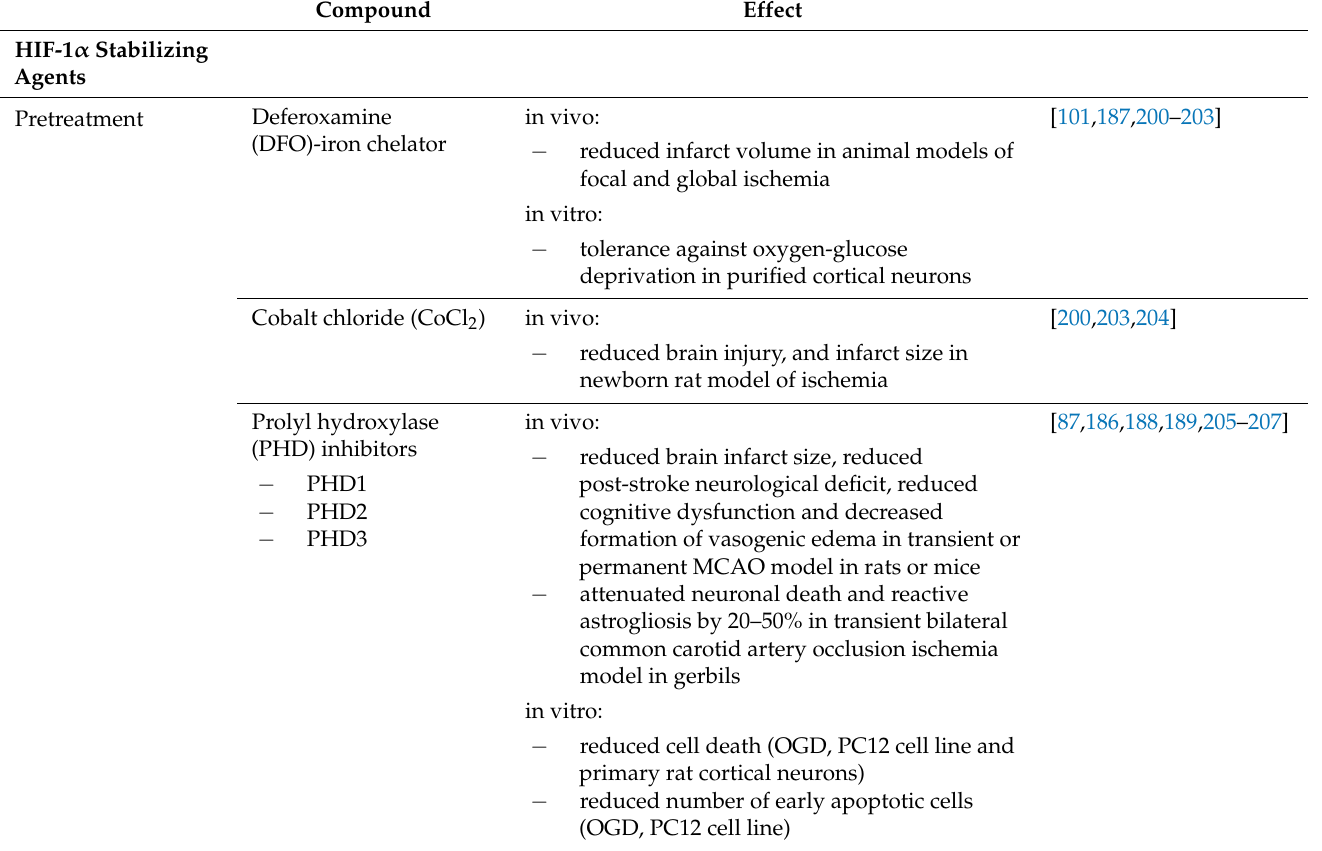
Table 2. HIF-1 α -based therapies. Pretreatment indicates that the compound was administered before experimental ischemia; posttreatment indicates that the compound was administered after the episode. MCAO—middle cerebral artery occlusion, ODG—oxygen and glucose